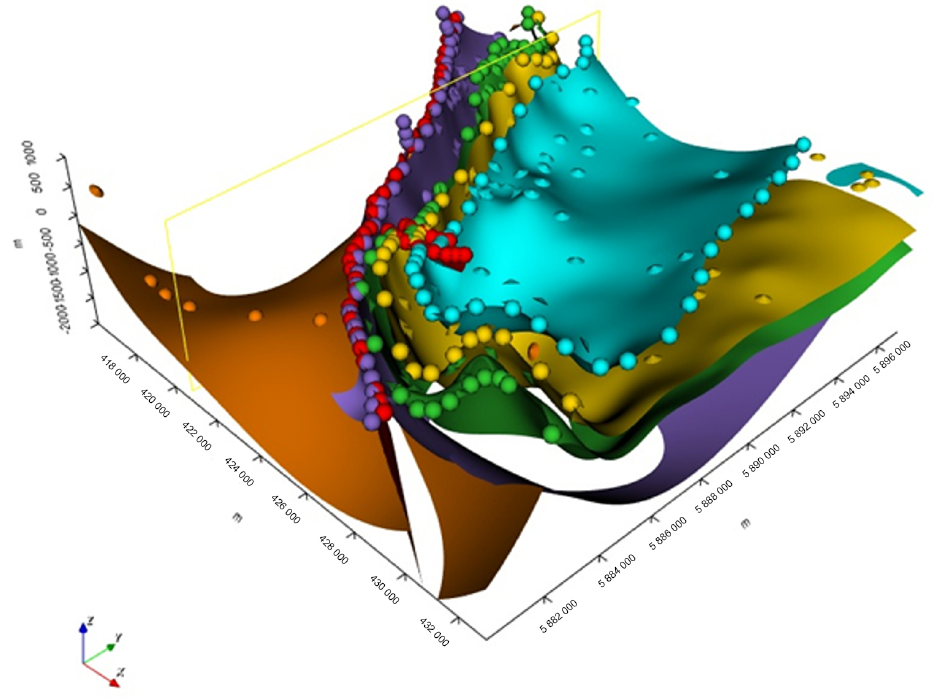
Figure 10. Structural data for the Mansfield model and modeled surfaces for units and faults. Spheres are interfaces and cones are